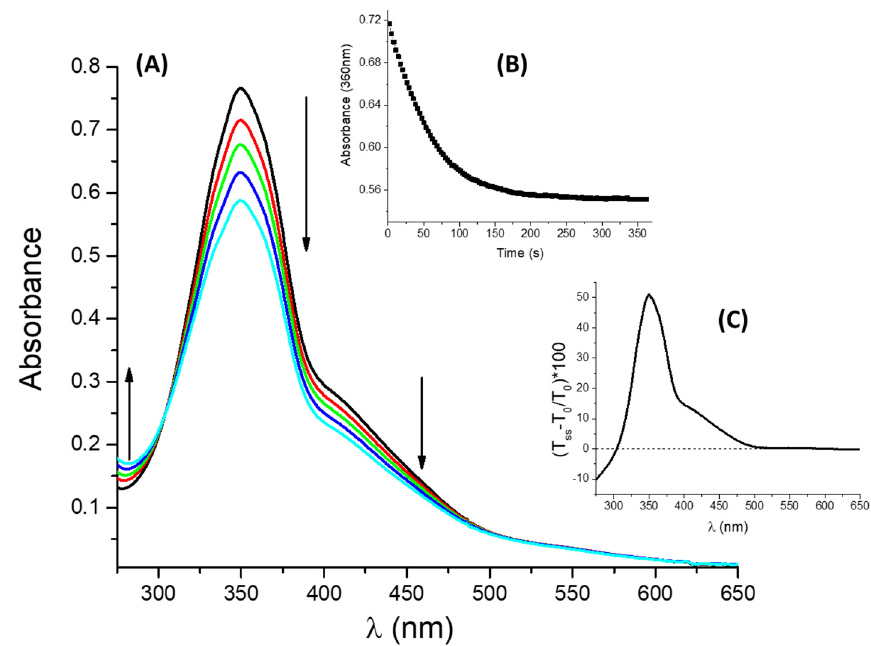
Figure 4. Spectral modifications ( A ) induced by a stationary UV irradiation at λ irr = ( 363 ± 40 ) nm for [ t -DZH ] = 4.2 × 10 − 5 M in [SB3-14] = 0.1 M: the arrows indicate the trends of absorbance in the different spectral regions (the black and cyan traces are the initial and final spectra, recorded before irradiation and at the photo-stationary state, respectively). Graph ( B ) shows how the absorbance at 360 nm changes upon UV irradiation. Graph ( C ) reports the trend of the relative percentage transmittance change, defined in Equation (3), as the function of wavelength.